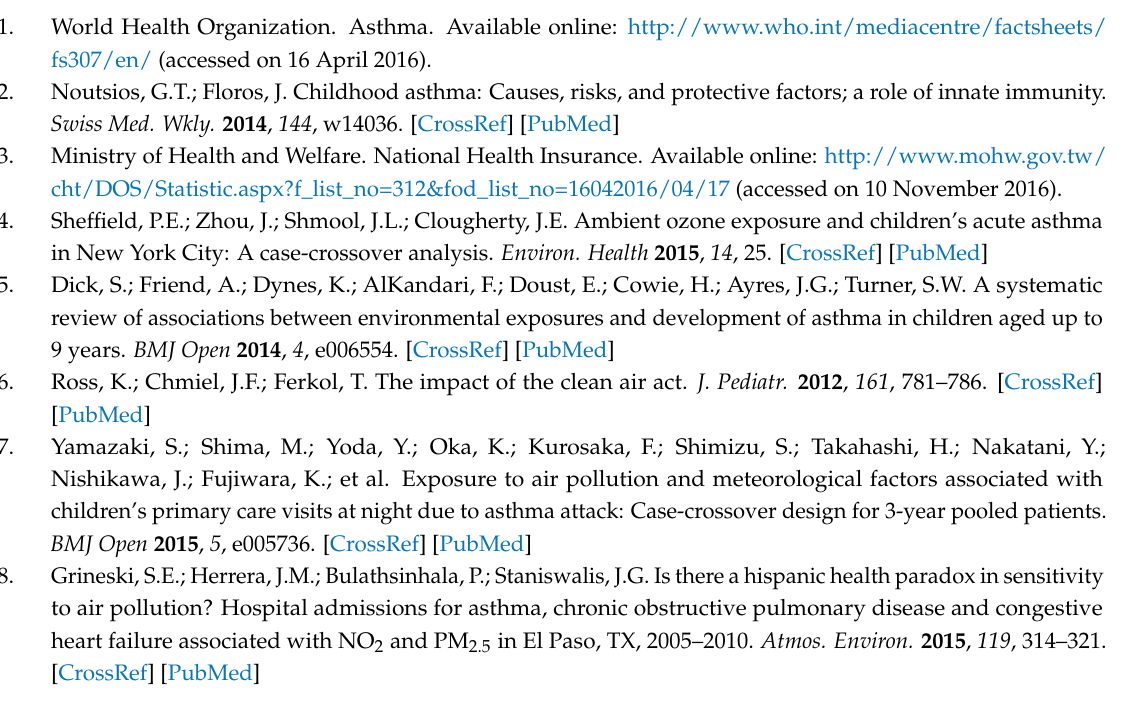
Table S1: Pearson correlation matrix of air